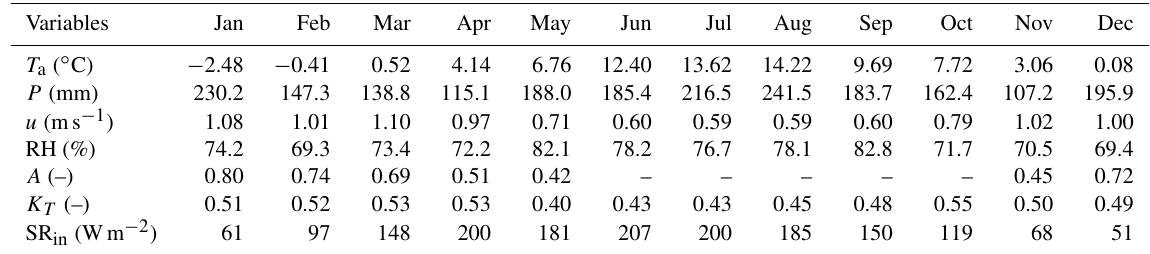
Table 1. Observed monthly average meteorological data at Brunnenkopfhütte (November 2016–May 2021).